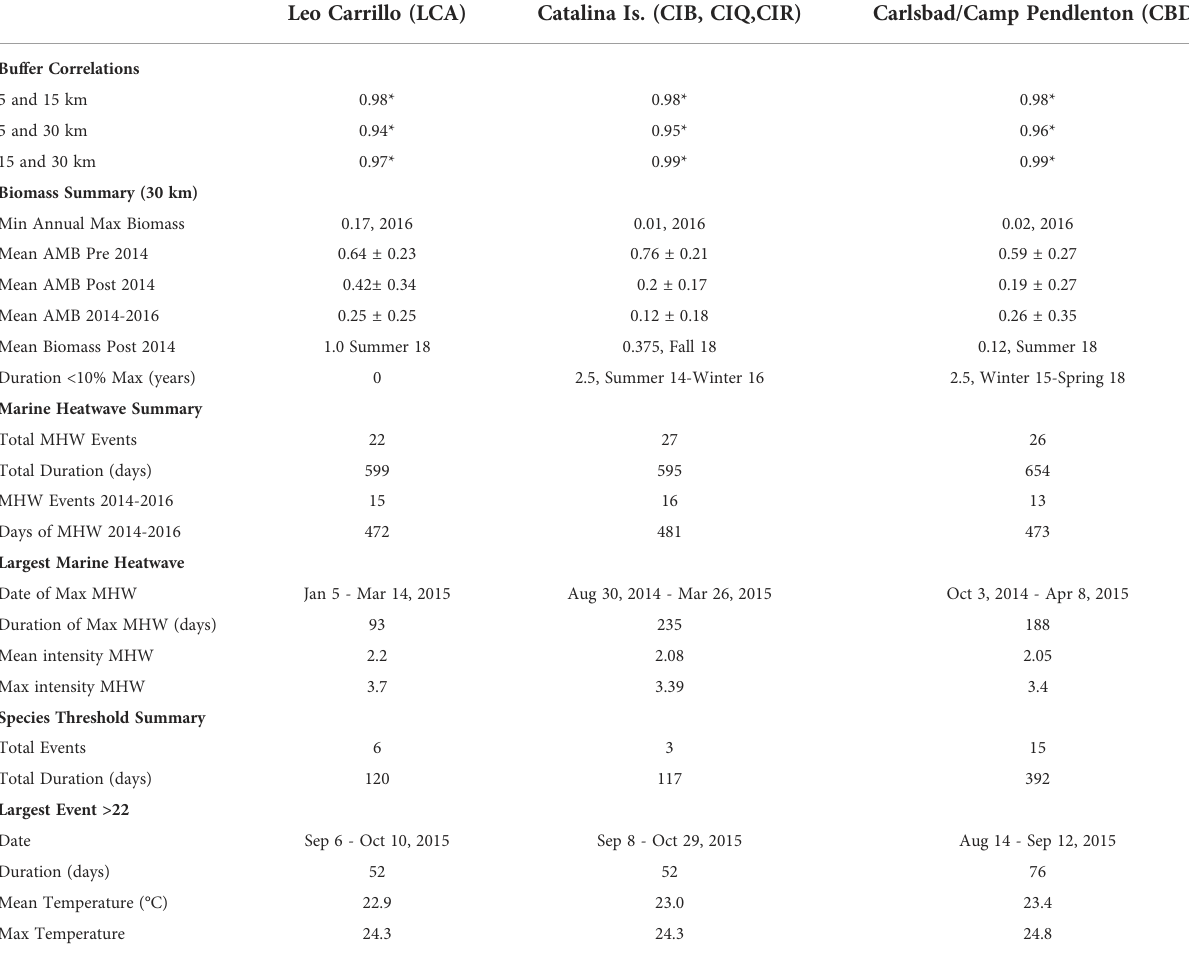
TABLE 1 Summary statistics for Macrocystis pyrifera canopy biomass (Landsat) and marine heatwave (MHW) analysis. Leo Carrillo (LCA) Catalina Is. (CIB, CIQ,CIR) Carlsbad/Camp Pendlenton